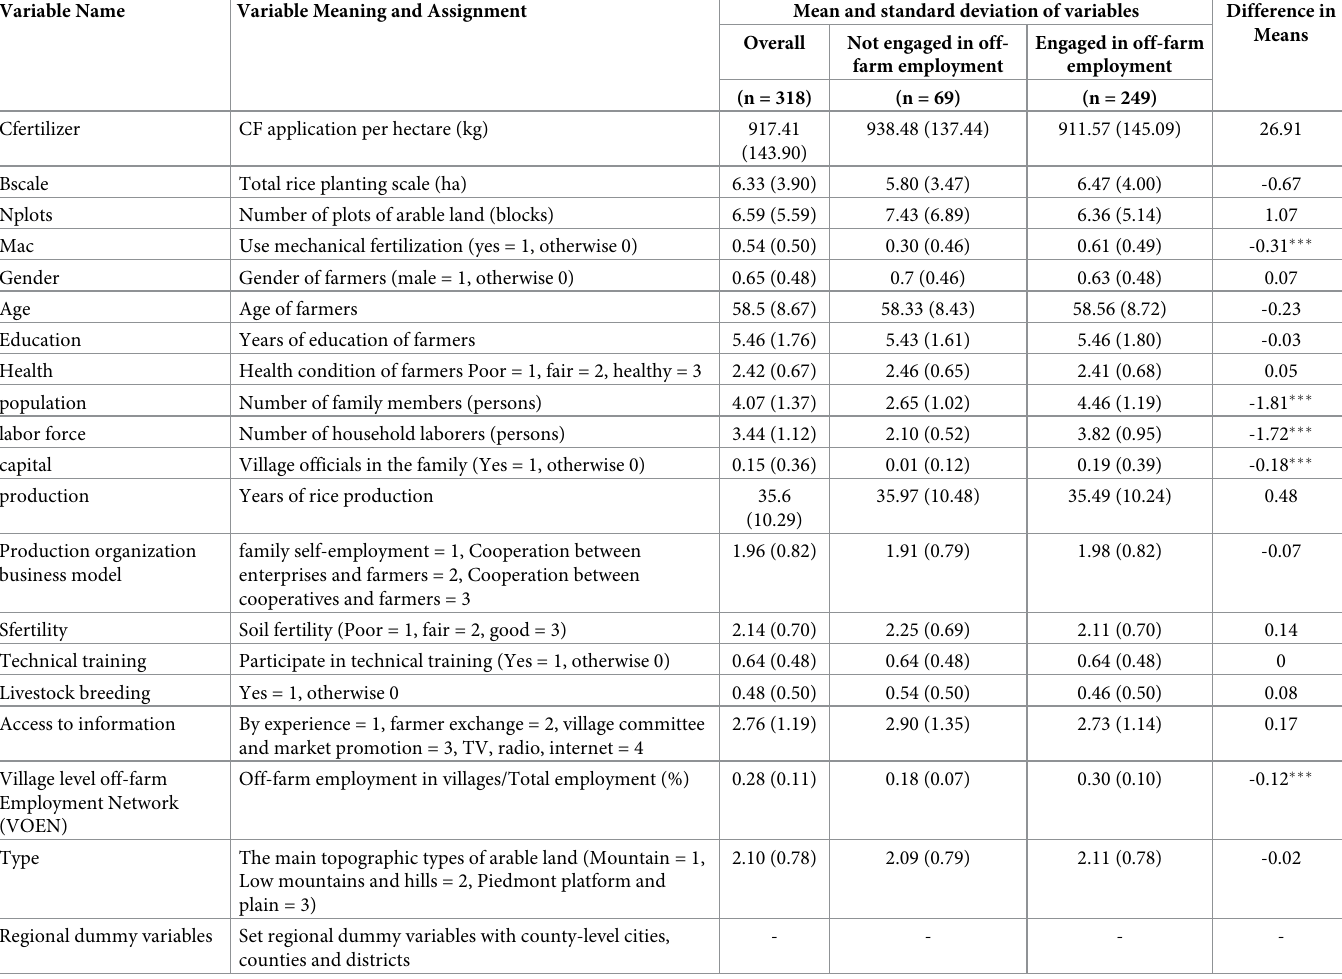
Table 2. Variable meanings and descriptive